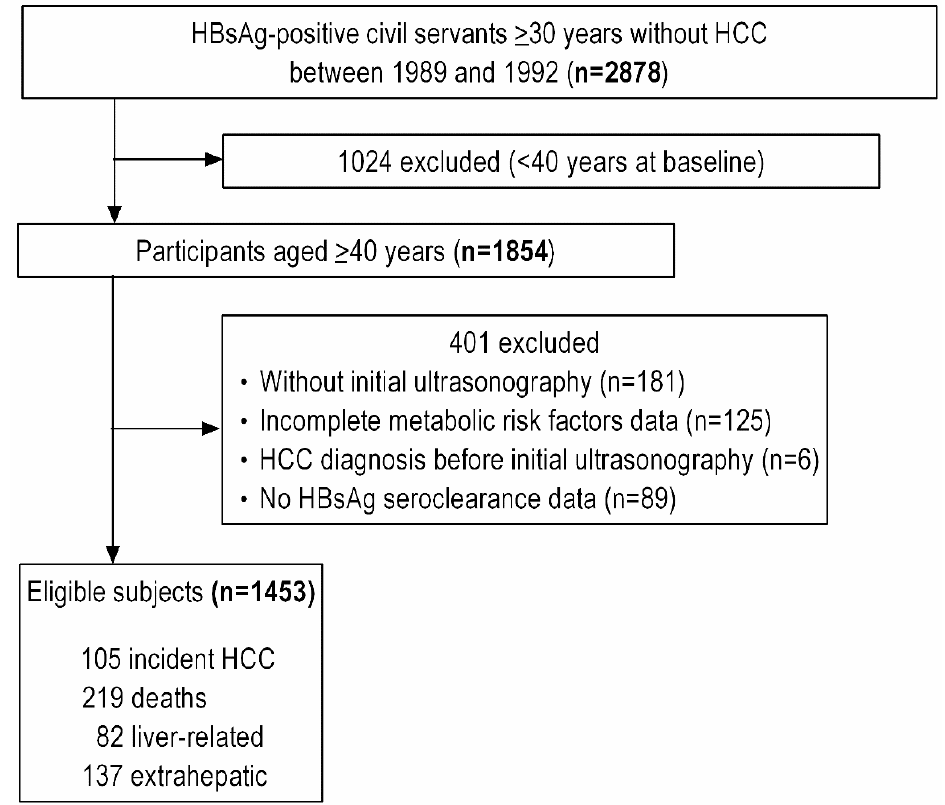
Figure 1. Flowchart of study population selection. HCC: hepatocellular carcinoma.